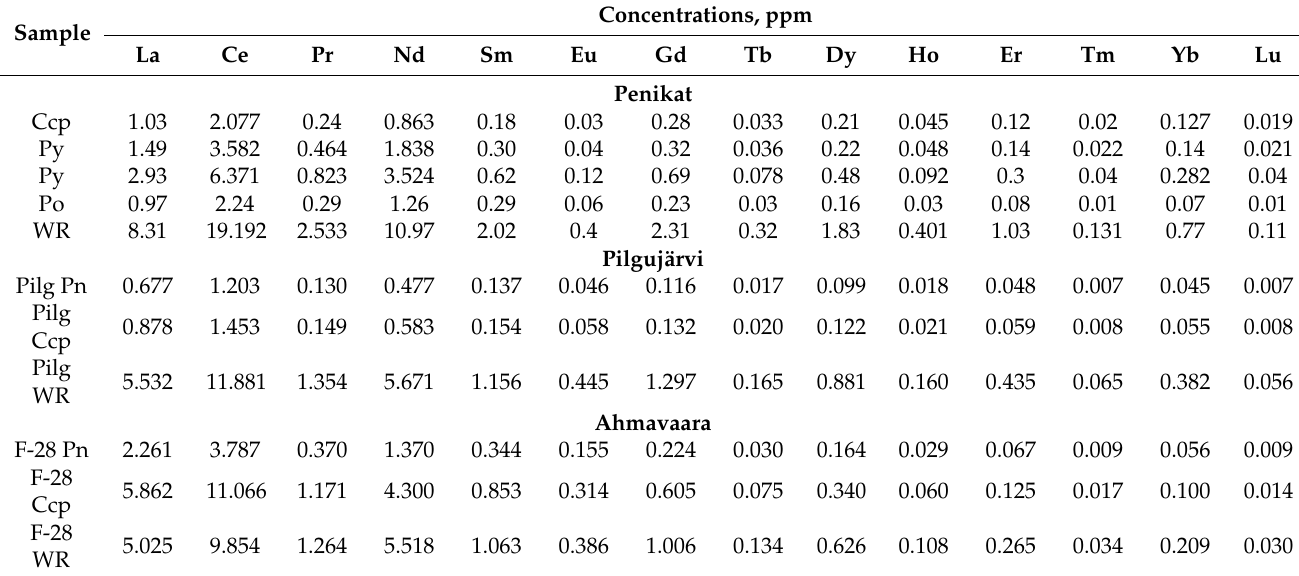
Table 3. ICP-MS data for rocks (WR) and sulfide minerals from Cu-Ni-PGE complexes of Fennoscandian Shield.